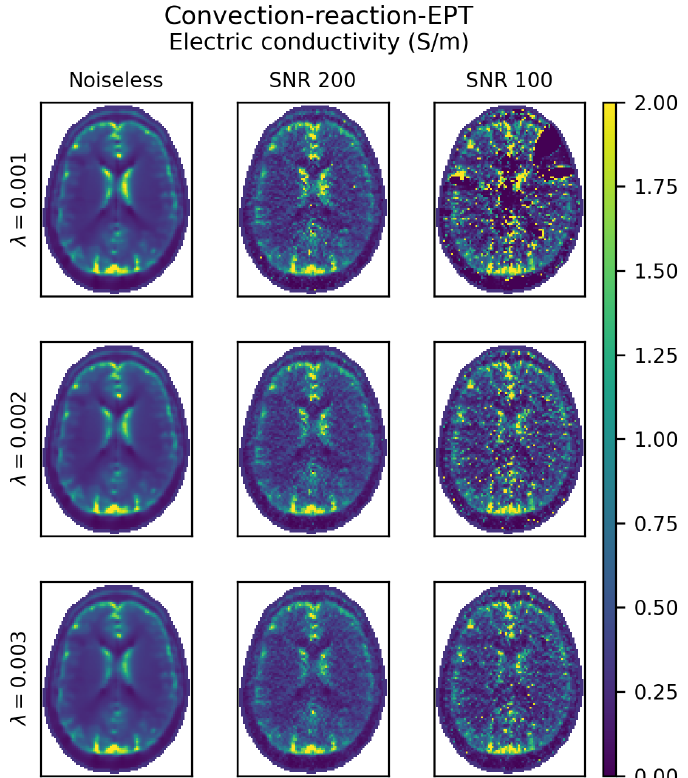
Figure 7. Electric conductivity distributions recovered by the phase-based approximation of convection-reaction-EPT with artificial diffusion regularization. All the distributions are recov- ered using a cross window of size [1,1,1] for the Savitzky–Golay filter. Different artificial diffusion coefficients are used ( λ = 0.001, 0.002 and 0.003) on input data with different amounts of noise (noise- less, signal-to-noise ratio—SNR = 200 and SNR = 100). To be compared with the actual distribution at 64MHz reported in Figure